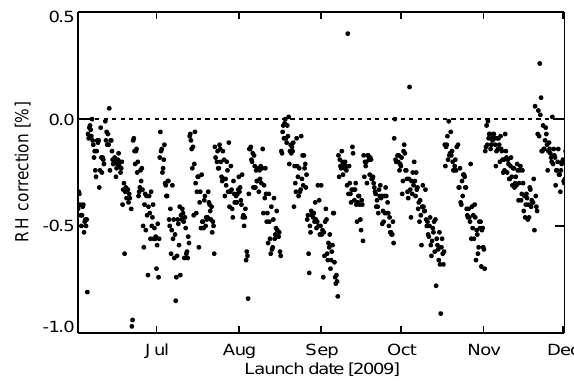
Figure 11. RH-sensor recalibration during ground check in the Fig. 11. RH-sensor recalibration during ground check in the GC25 for RS92 radiosondes launched at Linden- GC25 for RS92 radiosondes launched at Lindenberg in the second berg in the second half of 2009. The desiccant is replaced bi-weekly, or when the recalibration exceeds 1% half of 2009. The desiccant is replaced bi-weekly, or when the re- RH. calibration exceeds 1%